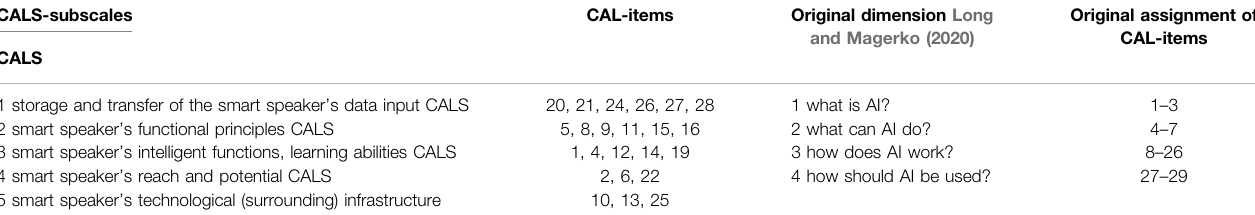
TABLE 2 | Empirically derived CALS-subscales and their items compared to the original dimension by Long and Magerko (2020). CALS-subscales CALS